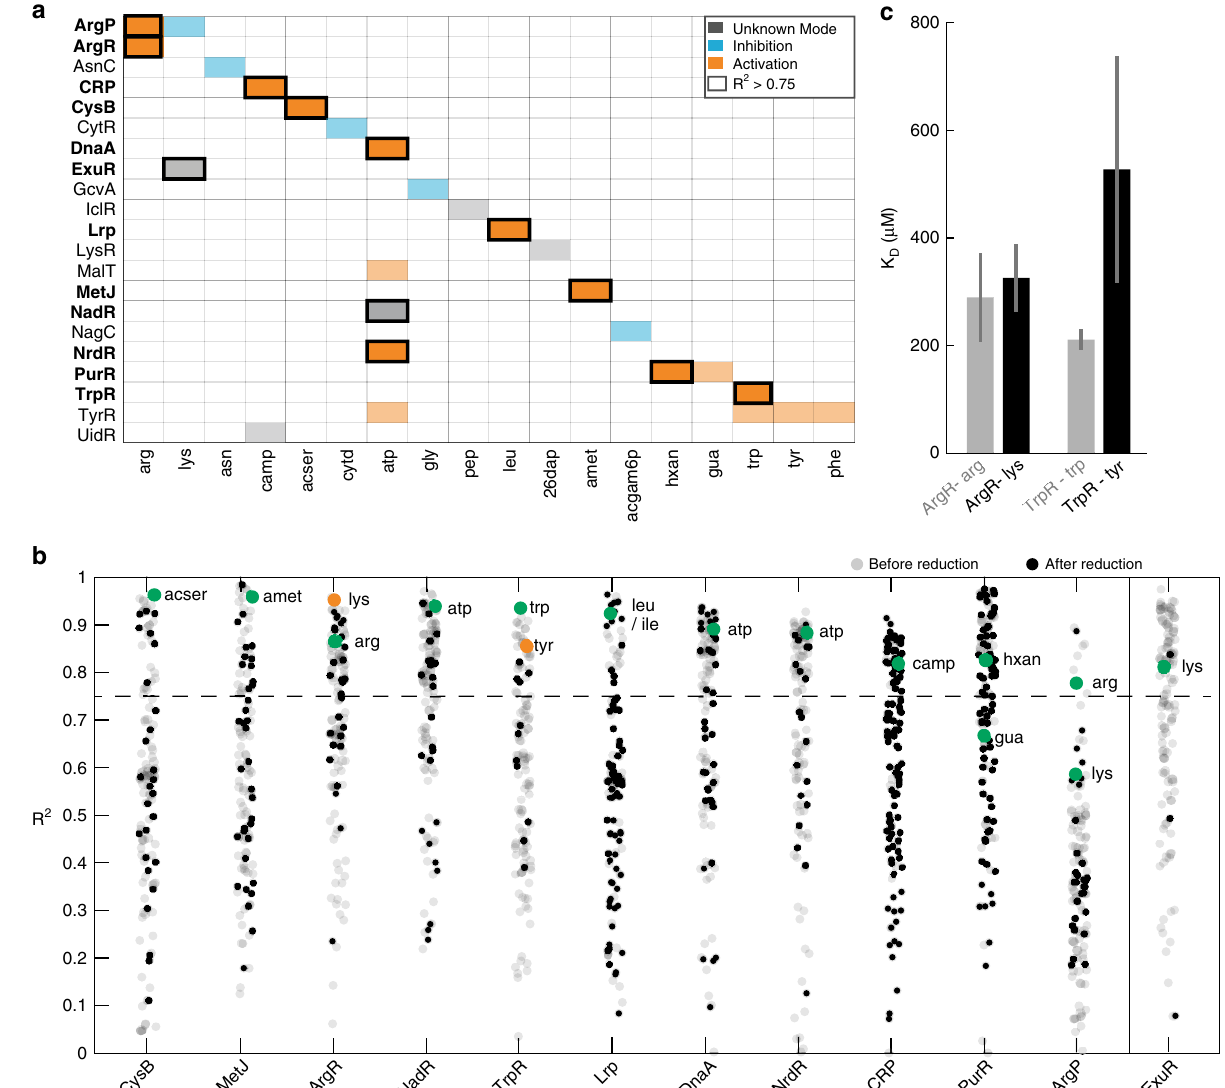
00.10.20.30.40.50.60.70.80.91 Fig. 4 Identi fi cation and validation of known metabolite-transcription factor interactions. a Metabolite – TF interactions that are described in the literature and covered by the metabolome data in Fig. 1c and the TF activities in Fig. 3a. Shown are 21 transcription factors (rows) and their respective effector metabolites (columns). Orange indicates an activation of the TF by the metabolite, blue indicates an inhibition, and gray indicates that the mode is unknown. Metabolite – TF pairs that show Hill-type kinetics in the metabolome and transcriptome data ( R ² > 0.75) are indicated with a box. b Correlation coef fi cients of 12 transcription factors, which had activity pro fi les that correlated with at least one of the known effector metabolites (green dots). Gray and black dots are correlation coef fi cients with all other 123 measured metabolites. Black dots are metabolites that ful fi ll the distance criterion (same metabolic subsystem or product/substrate of a target-gene). Gray dots are metabolites that are rejected by the distance criterion. For ExuR the distance criterion excluded the known effector lysine. Lysine and tyrosine are indicated in orange for ArgR and TrpR. c In vitro measured dissociation constants ( K D ) of ArgR and TrpR with the known effectors (arginine and tryptophan) and the predicted additional effectors (lysine and tyrosine). Binding was measured with His- tag puri fi ed ArgR and TrpR using micro scale thermophoresis (MST). Error bars show the 95% con fi dence interval of K D estimates, which are based on fi tting n = 9 MST assays (proteins puri fi ed three times, each measured in three MST assays). MST data are shown Supplementary Fig. 9. arg arginine, lys lysine, asn aspartate, acser O-acetyl-Serine, cytd Cytidine, atp adenosine triphosphate, gly glycine, pep phosphoenolpyruvate, leu leucine, 26dap diaminopimelic acid, amet S-adenosylmethionine, acgam6p N-acetyl-glucosamine phosphate, hxan hypoxanthine, gua guanine, trp tryptophan, tyr tyrosine, phe phenylalanine. Source data are provided as a Source Data fi the distance criterion (black dots in Fig. 4b). For the 12 known Among the false positives that remained after the distance fi lter metabolite – TF interactions that showed a Hill-type relation- were lysine – ArgR and tyrosine – TrpR (orange dots in Fig. 4b). ship, 11 ful fi lled the distance criterion, and only the interaction Because lysine and tyrosine share structural similarity with the between ExuR and lysine was rejected. The advantage of the known allosteric effectors (arginine for ArgR and tryptophan for distance fi lter was that it reduced the number of highly corre- TrpR), we tested if lysine and tyrosine are additional and previously lating metabolites from an average of 34 metabolites per TF to unidenti fi ed regulators of ArgR and TrpR. Therefore, we puri fi ed an average of 9 (Fig. 4b). the two TFs and tested binding of lysine and tyrosine in vitro using